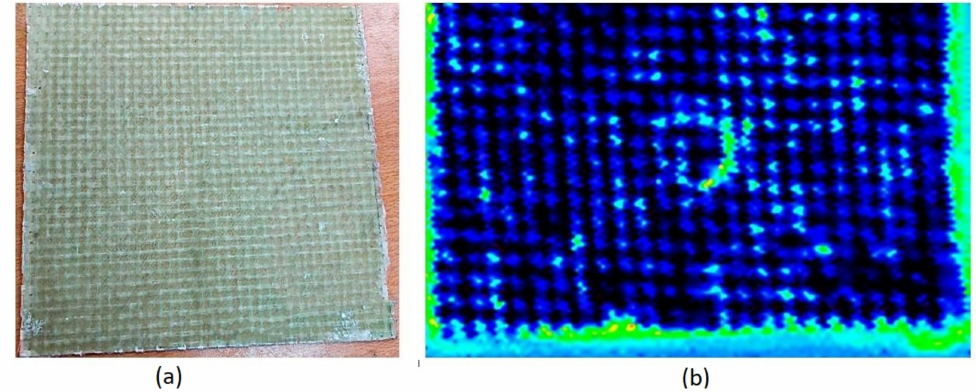
Figure 6. GFRP panel ( a ) and C-Scan representation of the ultrasonic inspection ( b ), showing damage caused by repeated slamming impacts.